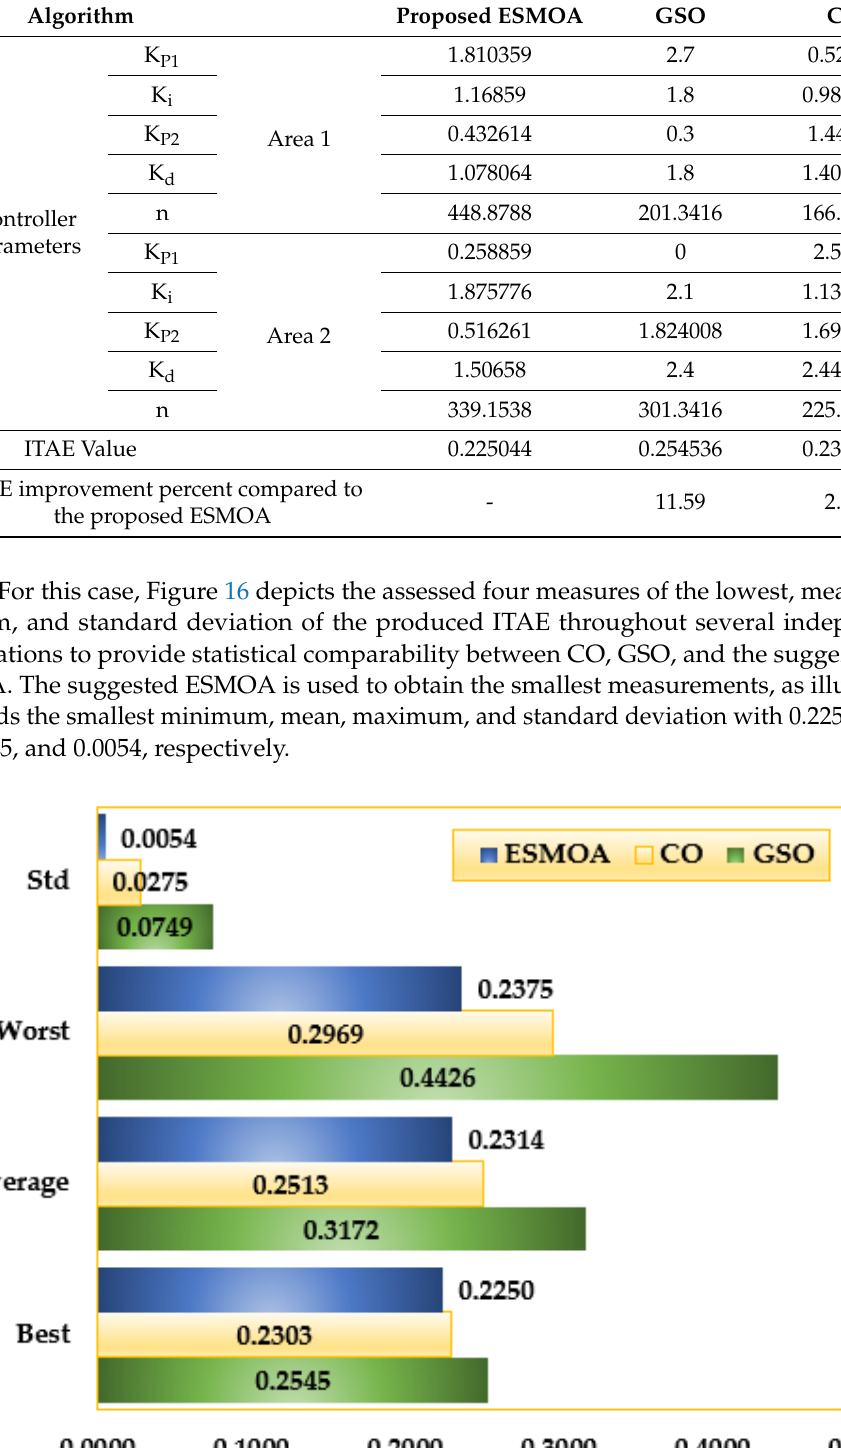
Table 9. Results for Case 4.